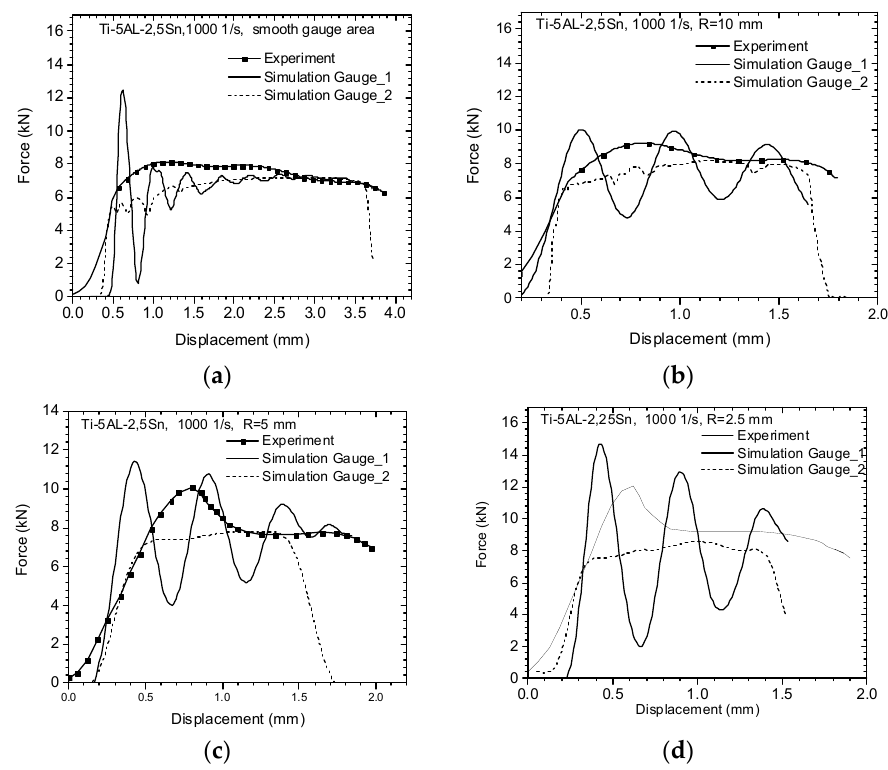
Figure 13. Calculated and experimental force–displacement curves; ( a ) specimen without a notch, ( b ) notch radius R = 10 mm, ( c ) notch radius R = 5 mm, and ( d ) notch radius R = 2.5 mm.